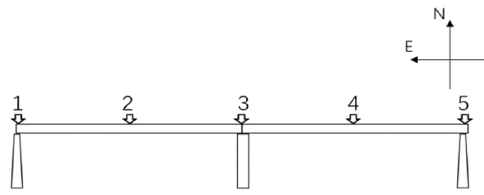
Figure 4. Longitudinal section layout of the bridge.